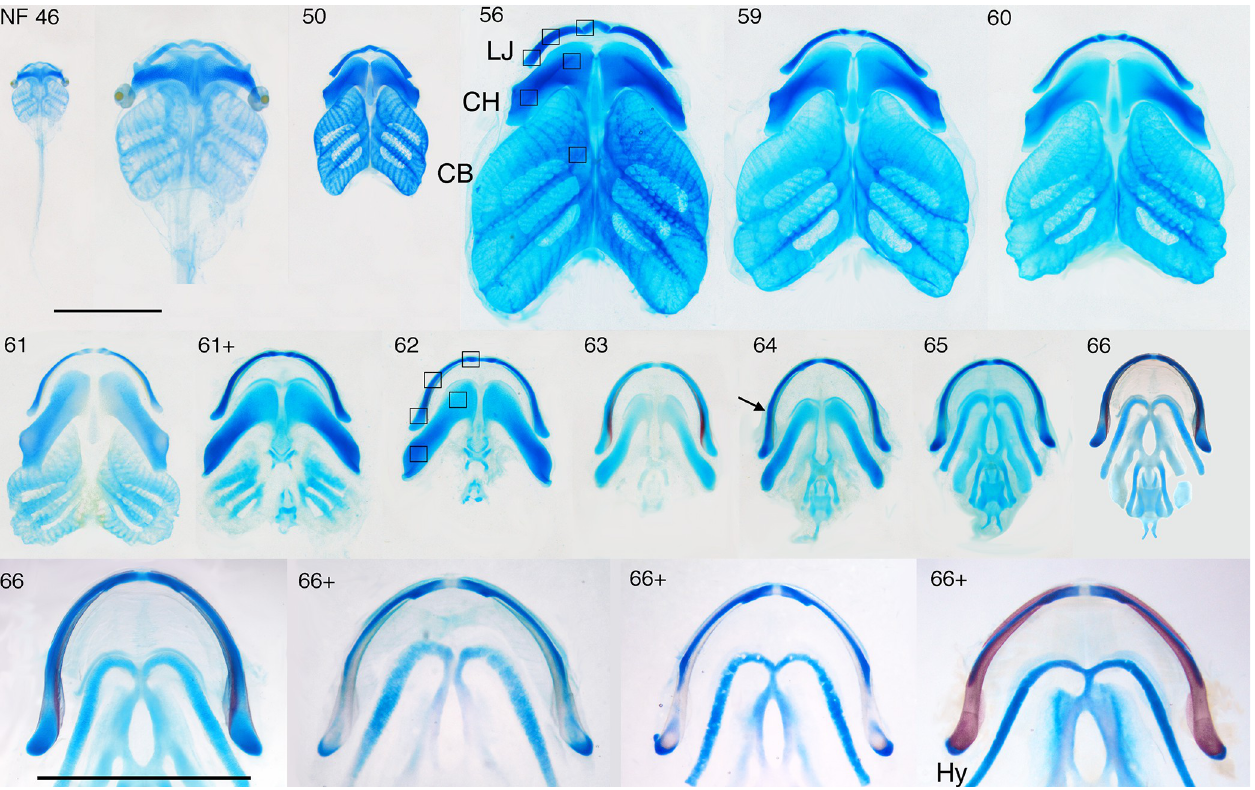
Fig 1. Ventral views of dissected, skeletally stained viscerocranial skeletons for NF 46–66+. Blue is cartilage, red is bone; LJ, lower jaw (the small, separate cartilage near the midline in NF 46–62 is the infrarostral, the larger, more lateral one is Meckel’s cartilage); CH, ceratohyal; CB, the first ceratobranchial (the four collectively are the branchial basket): HY; adult hyale; the boxes show the approximate regions selected in frontal sections for quantifying cell features; scale bars are 5 mm and apply to all panels except the second one in which the NF 46 skeleton is expanded to a comparable size with the NF 50 skeleton; arrow indicates the inflection point in lower jaw curvature; NF 46–59 covers tadpole growth, NF 59–66 covers metamorphosis, and the NF 66–66+ series spans approximately 5 days after NF 66. The NF 66–66+ series shows three postmetamorphic changes: loss of LJ cartilage just anterior to the joint, expansion of the adjacent dermal bones, and changes in CH histology. Modified with permission from